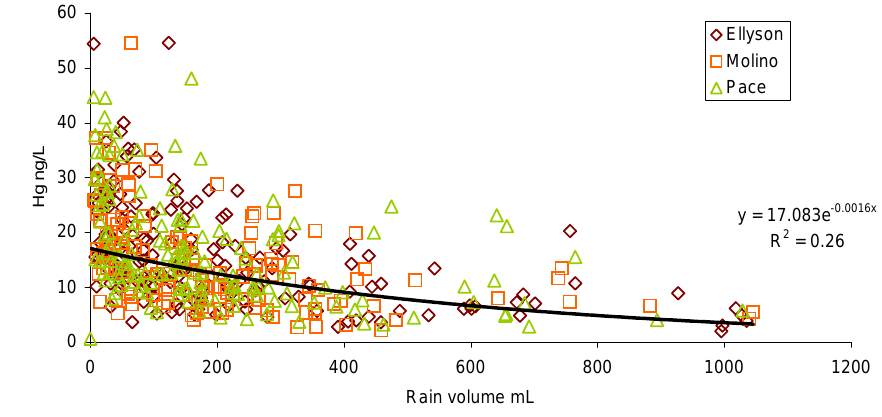
Fig. 2. Mercury (Hg ng/L) concentration versus the volume of rain (mL) collected in sample bottles at Pensacola Bay